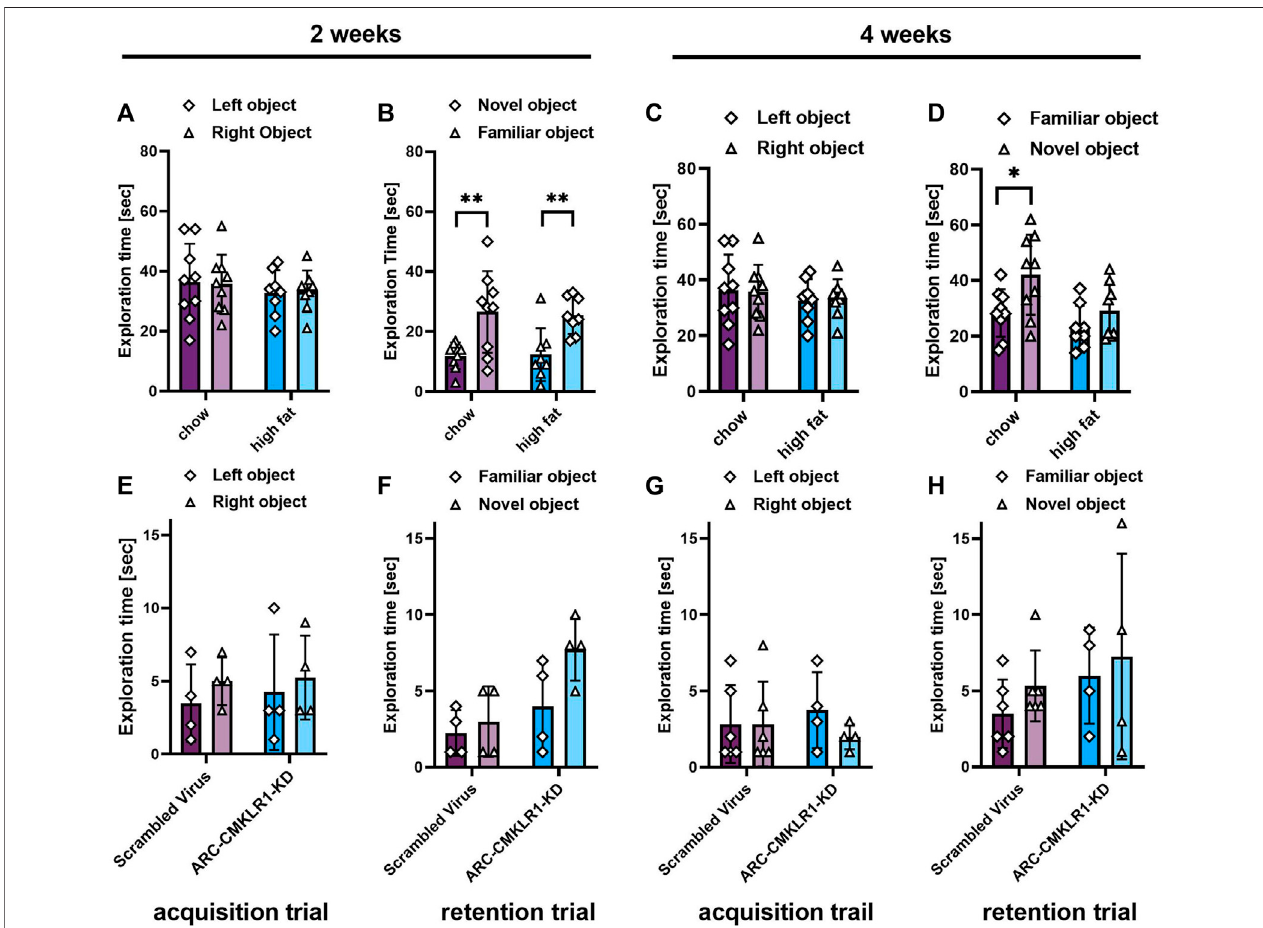
FIGURE6 | Short term memory effects ofCMKLR1knockdown in the arcuate nucleus. (A – D) Initially, performancein the Novel object recognition(NOR) task was tested in Sprague Dawley rats on nutrient-matched chow or high-fat diet. (E – H) Sprague Dawley rats on high-fat diet received bilateral injections of a shRNA construct targetedagainstCMKLR1oracontrolconstruct( n =8/group).Aftersurgery,theratsweremaintainedonahigh-fatdietfor17 daysandthenswitchedtochowdiet. (A,E) Meanexplorationtimeofidenticalobjectsintheacquisitiontrialafter2 weeks. (B,F) Meanexplorationtimeofafamiliarobjectandanovelobjectintheretentiontrial after 2 weeks. (C,G) Mean exploration time of identical objects in the acquisition trial after 4 weeks. (D,H) Mean exploration time of a familiar object and a novel object in theretentiontrialafter4 weeks.DatawereanalyzedbyStudent ’ spaired t -test.* p < 0.05, p < 0.01.Ratsthatfailedtoexplorebothobjectsinoneorbothtrialsofthetasks were excluded from the analysis, therefore the fi nal group numbers were n = 4 – 9. Data are expressed as mean ± SD.